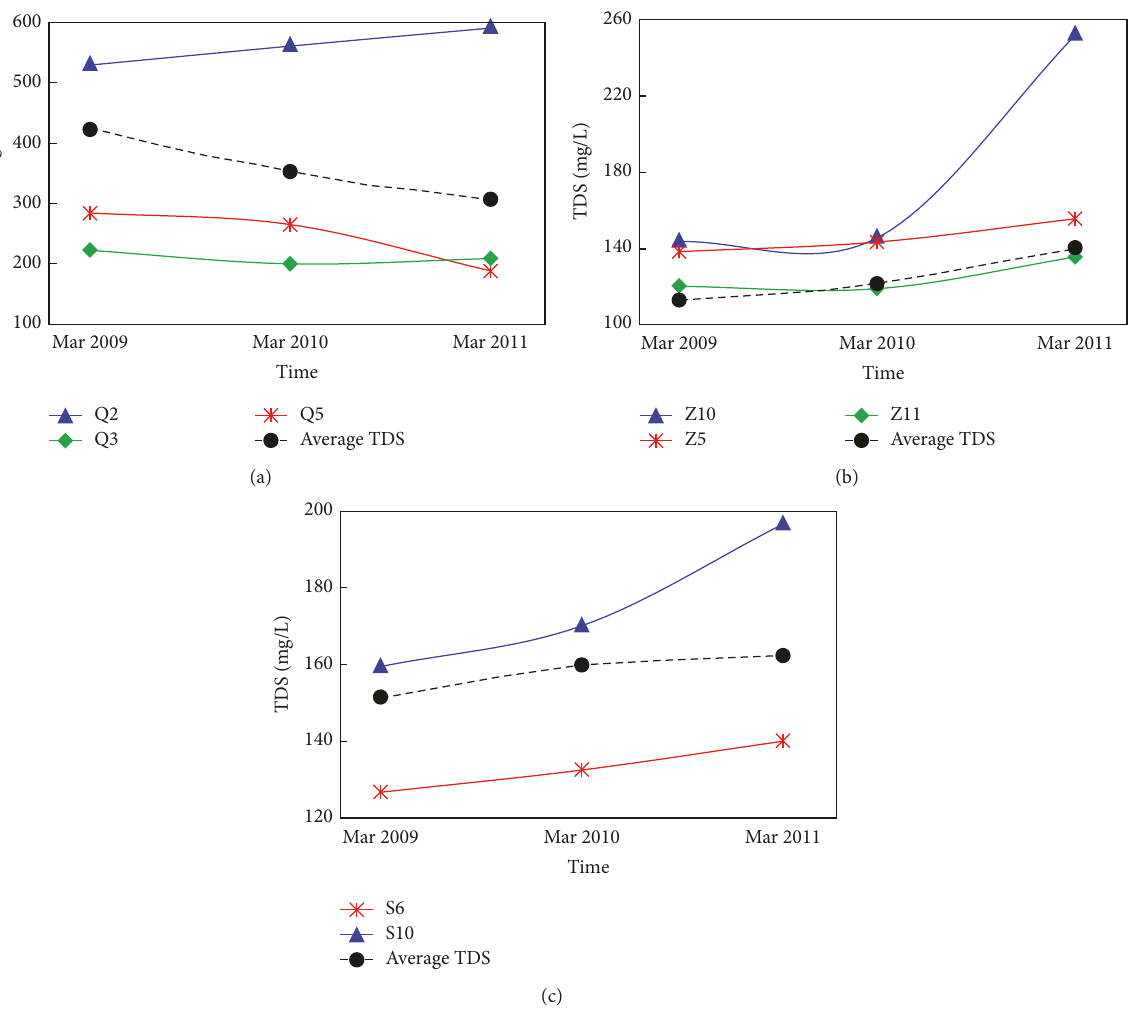
Figure 12: Salinity dynamics in the multilayered aquifers during 2009–2011. (a) TDS dynamics of the unconfined aquifer. (b) TDS dynamics of the middle confined aquifer. (c) TDS dynamics of the deep confined